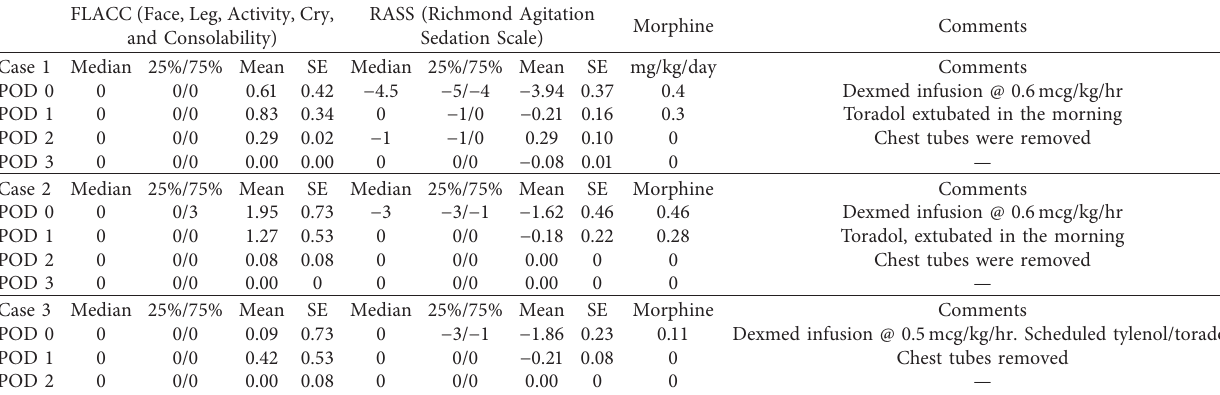
Table 1: Median, 25% and 75%, mean, and standard error (SE) values for the FLACC pain score (Face, Leg, Activity, Cry, and Consolability) and RASS score (Richmond Agitation Sedation Scale). Ranges of FLACC scores observed were 0 to 10 in total. Ranges of RASS scores observed were − 5 to +4. The comments column details important clinical events that could contribute to pain scores. Morphine was the sole opioid administered postoperatively in all cases.